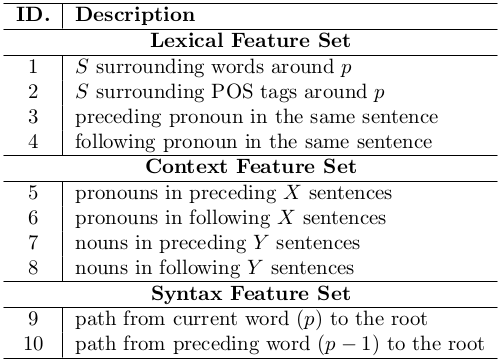
Table from the paper: A Novel Approach to Dropped Pronoun Translation
Table text:
ID.
Description
LexicalFeatureSet
1
Ssurroundingwordsaroundp
2
SsurroundingPOStagsaroundp
3
precedingpronouninthesamesentence
4
followingpronouninthesamesentence
ContextFeatureSet
5
pronounsinprecedingXsentences
6
pronounsinfollowingXsentences
7
nounsinprecedingY sentences
8
nounsinfollowingY sentences
SyntaxFeatureSet
9
pathfromcurrentword(p)totheroot
10
pathfromprecedingword(p − 1)totheroot